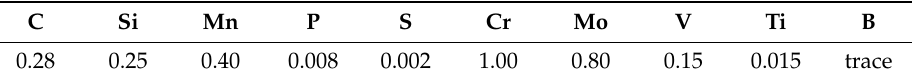
Table 6. Chemical compositions of 28CrMo48VTiB steel (wt %).